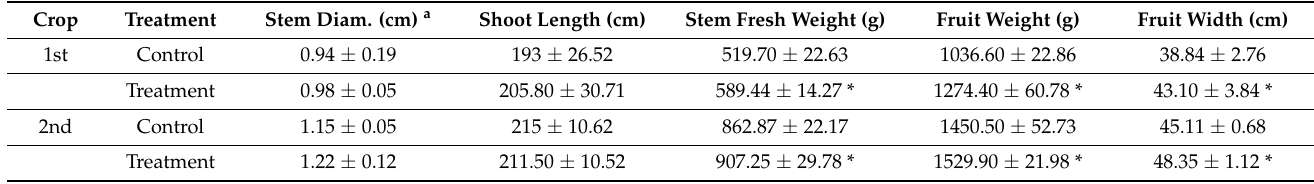
Table 2. Effect of Trichoderma asperelloides PSU-P1 on muskmelon growth. Stem Diam. Crop Treatment Table 3. Effect of Trichoderma asperelloides PSU-P1 on postharvest quality of